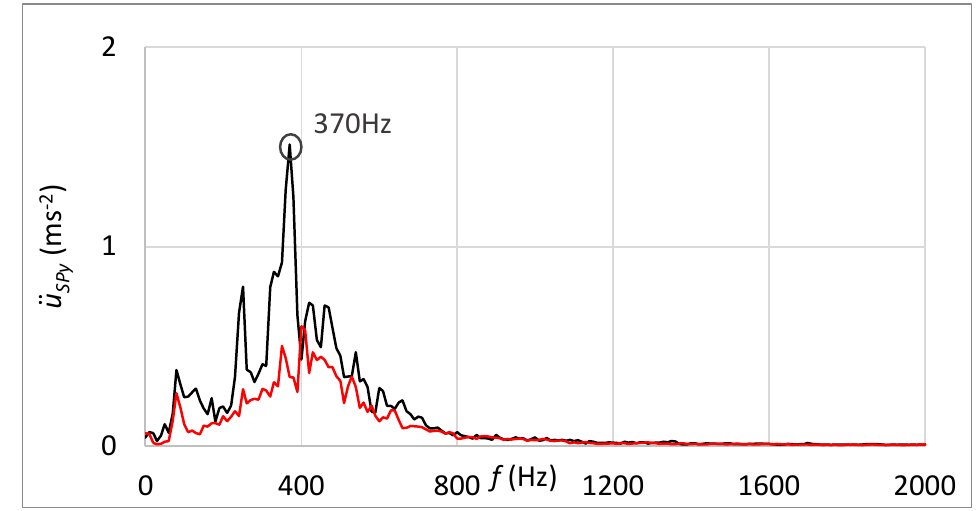
Figure 20. Frequency spectrum of vibrations with the sensor connection by the rubber spring and additional weight; black: the damage of the guiding profile; red: without the damage.